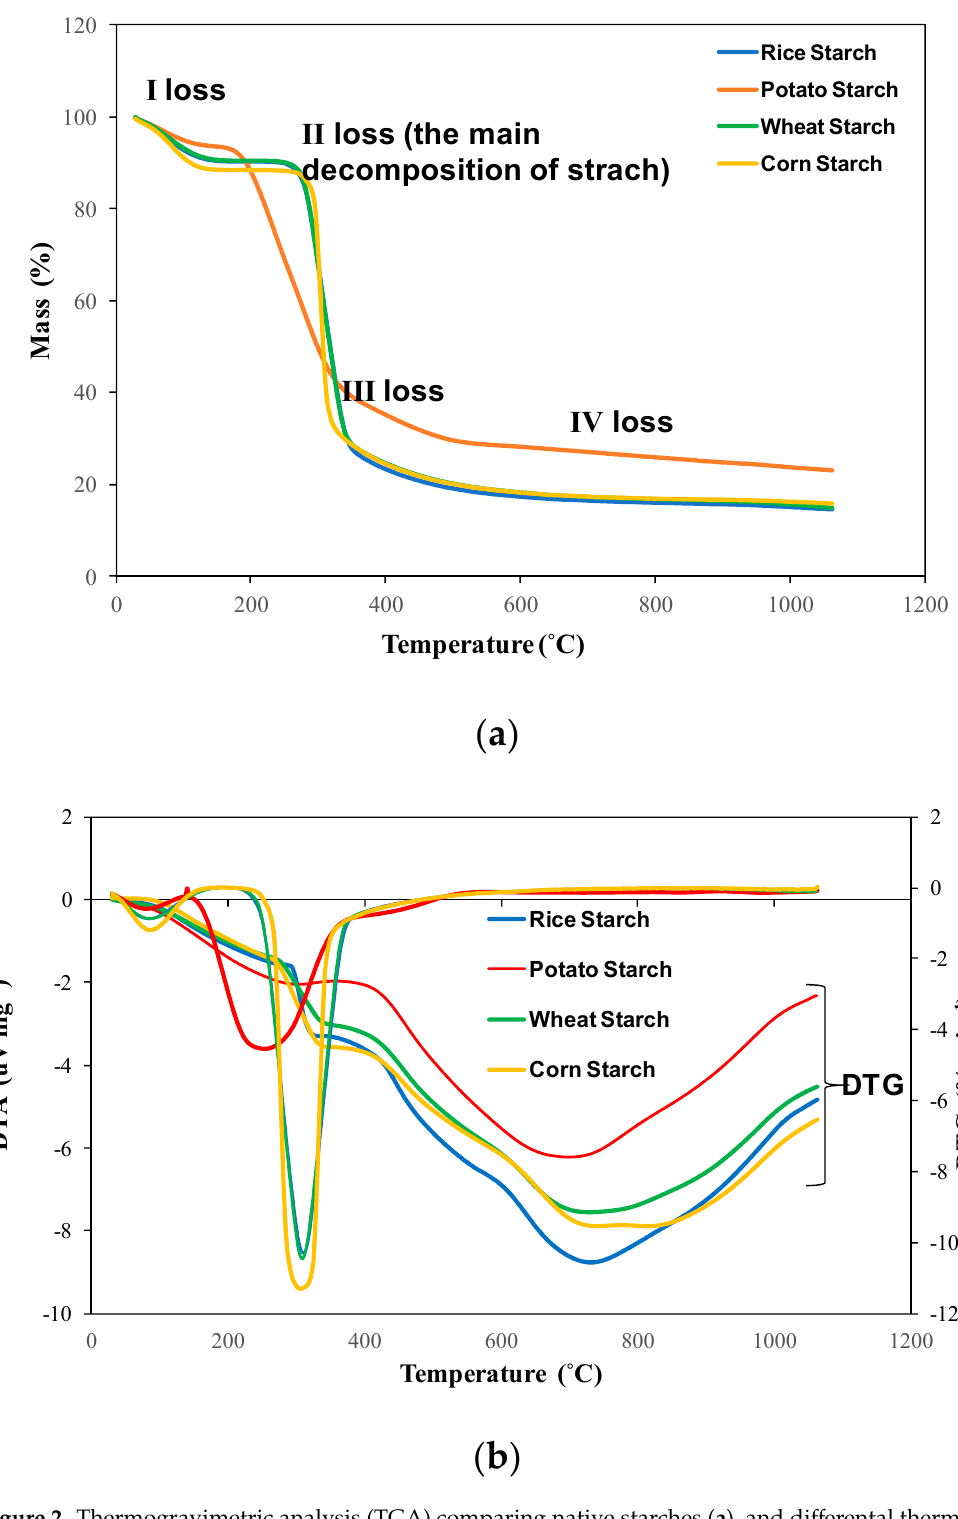
Figure 2. Thermogravimetric analysis (TGA) comparing native starches ( a ), and differental thermal analysis (DTA) and difference thermal gravimetry (DTG) comparing native starches ( b ).